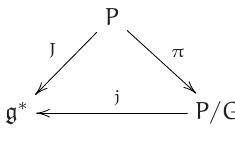
Figure 3.1. The momentum map J factors through delivering a map j : P/G → U ⊂ g ∗